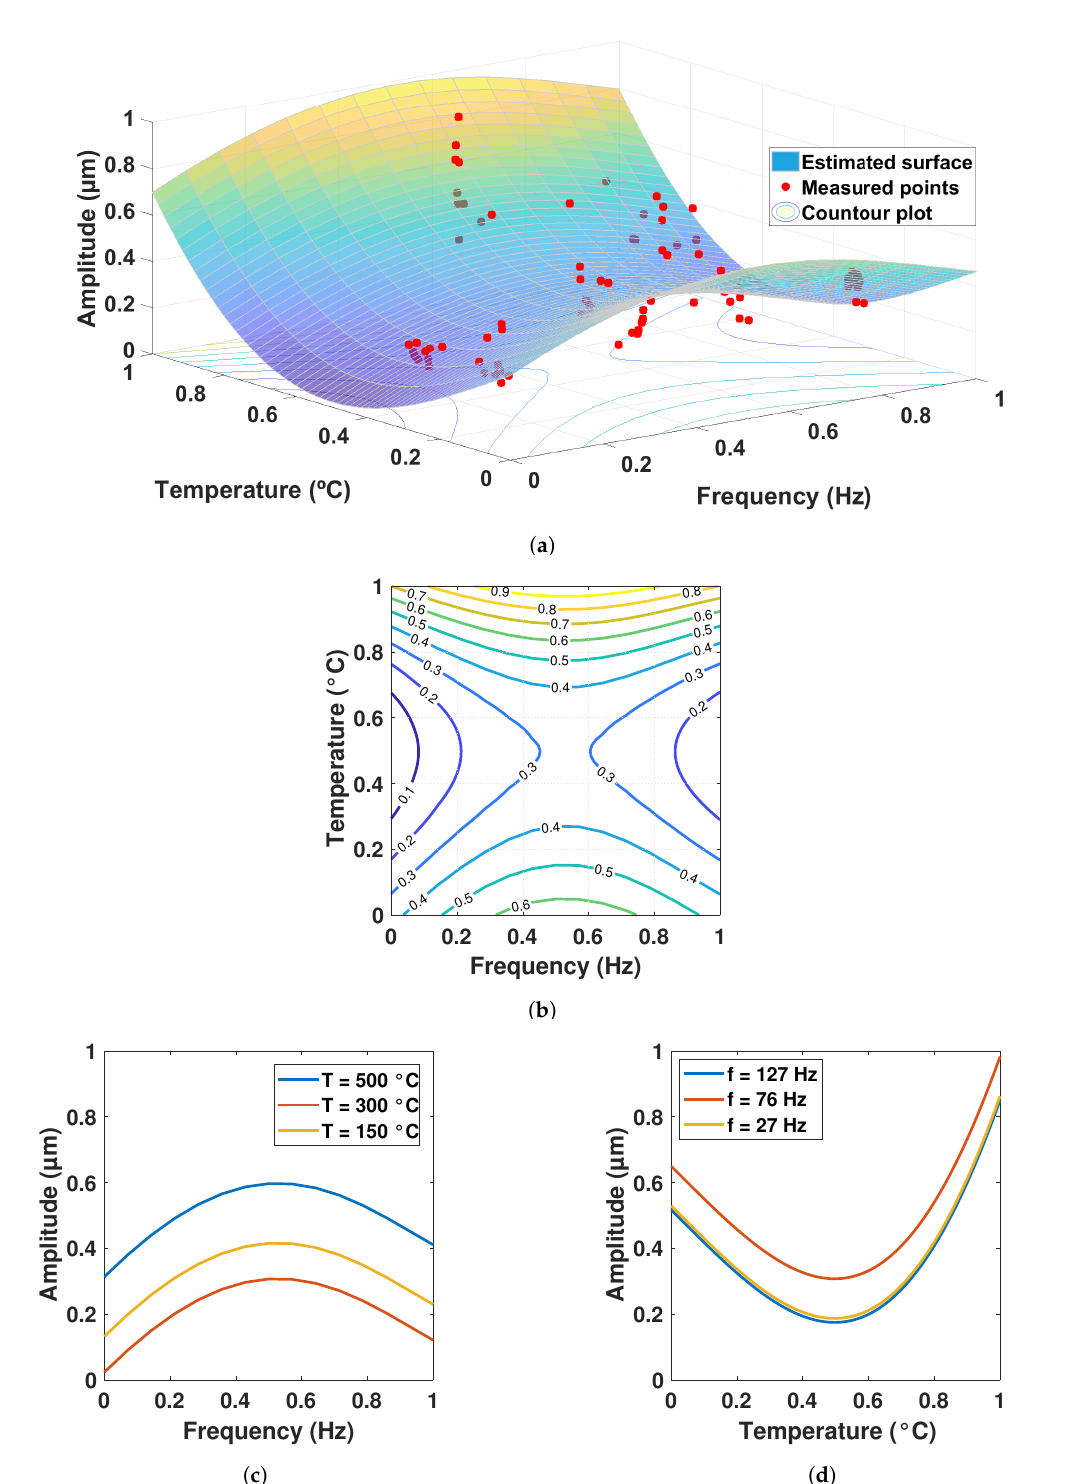
Figure 6. Results from the 5th order polynomial using the 80-point sample: ( a ) Surface response model fitting the sample; ( b ) Contour plot from the surface response model; ( c ) Amplitude vs. frequency when setting the nominal temperature values; ( d ) Amplitude vs. temperature when setting the nominal